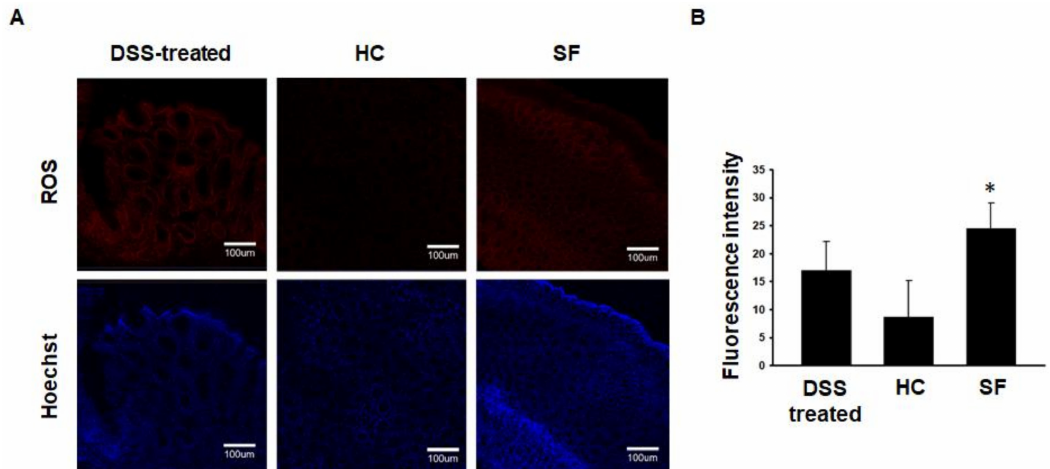
Figure 3. Confocal microscopic images showing ROS in colon tissue from mice in the DSS-treated, HC, and SF groups. ( A ). Representative confocal images of ROS in the colons of mice in the 2% DSS-treated (n = 3), HC (n = 5), and SF (n = 5) groups. ( B ). Comparison of fluorescence intensity showing ROS in colon tissues across the groups. Data are presented as the mean ± S.E.M. * p < 0.05